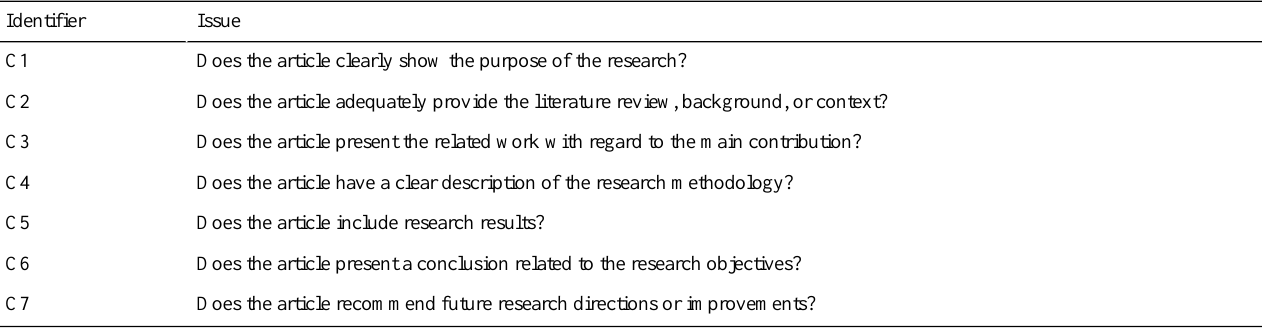
Table 1. Quality criteria for the included